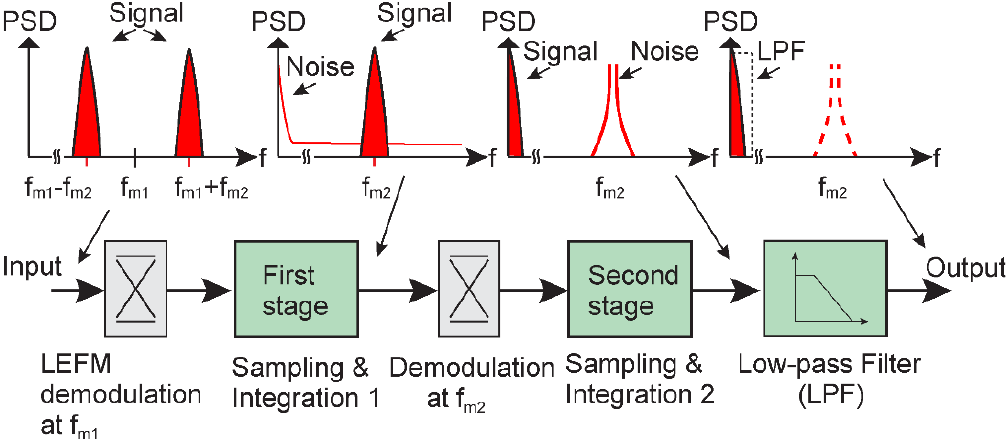
Figure 2. Overall noise reduction process through the in ‐ pixel double ‐ demodulation.